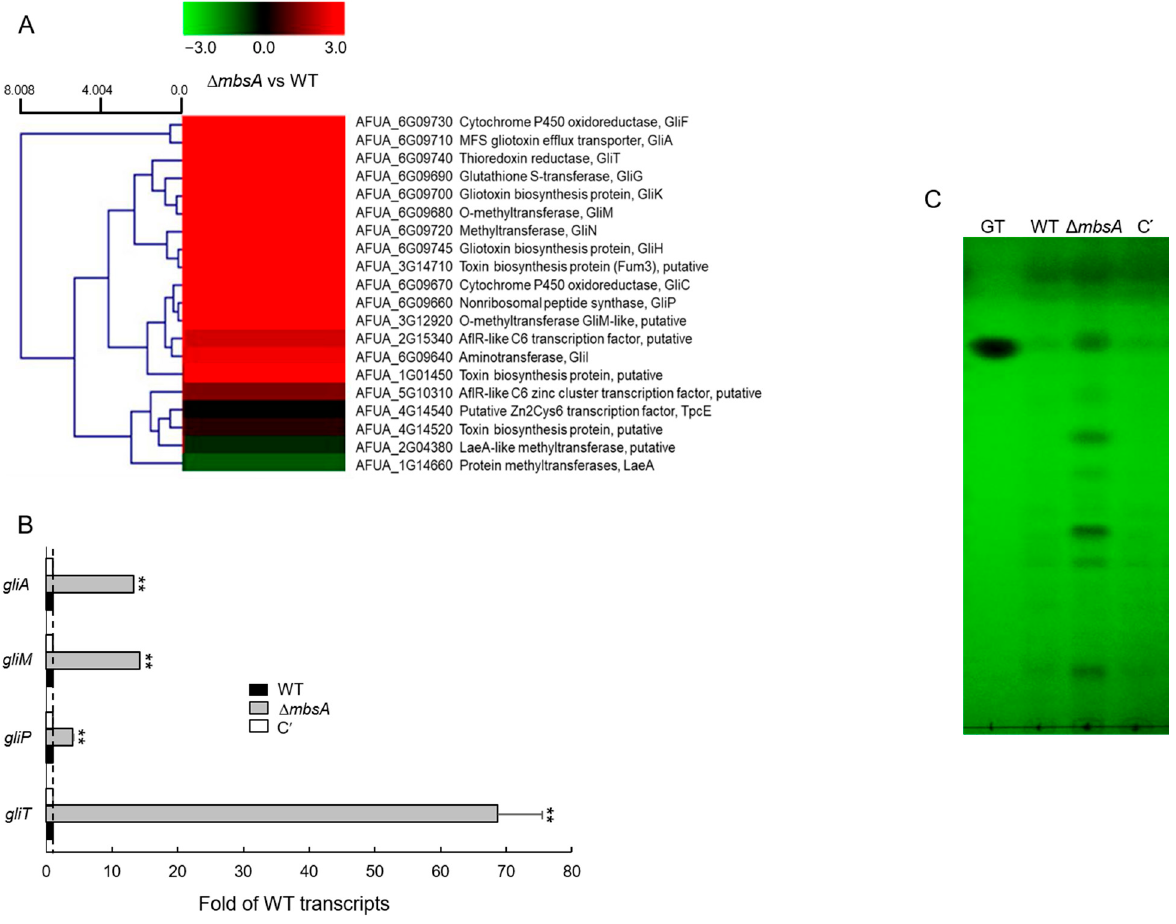
Figure 7. MbsA down-regulates gliotoxin (GT) production. ( A ) Heat map of those genes encoding toxin-related proteins. Most of gliotoxin biosynthetic genes were up-regulated by the loss of mbsA . ( B ) Determination of GT production in WT, Δ mbsA , and C ′ strains. The culture supernatant of each strain was extracted with chloroform and subjected to TLC. ( C ) RT-qPCR analysis of GT-related genes in WT, Δ mbsA , and C ′ strains. The ef1 α gene as the endogenous control. Statistical differences between WT and mutant strains were evaluated with ANOVA test: ** p < 0.01.